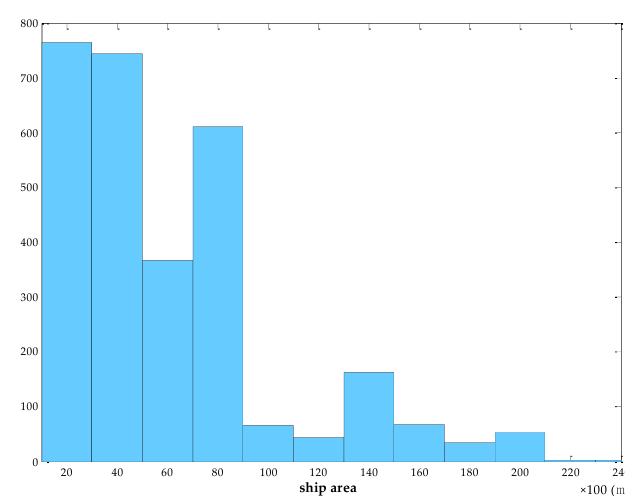
Figure 5. The distribution of the ship area in the Sentinel-1 dataset (only the ships have Automatic Identification System (AIS) information). More than 85% of ships have an area smaller than 80 pixels on SAR images.